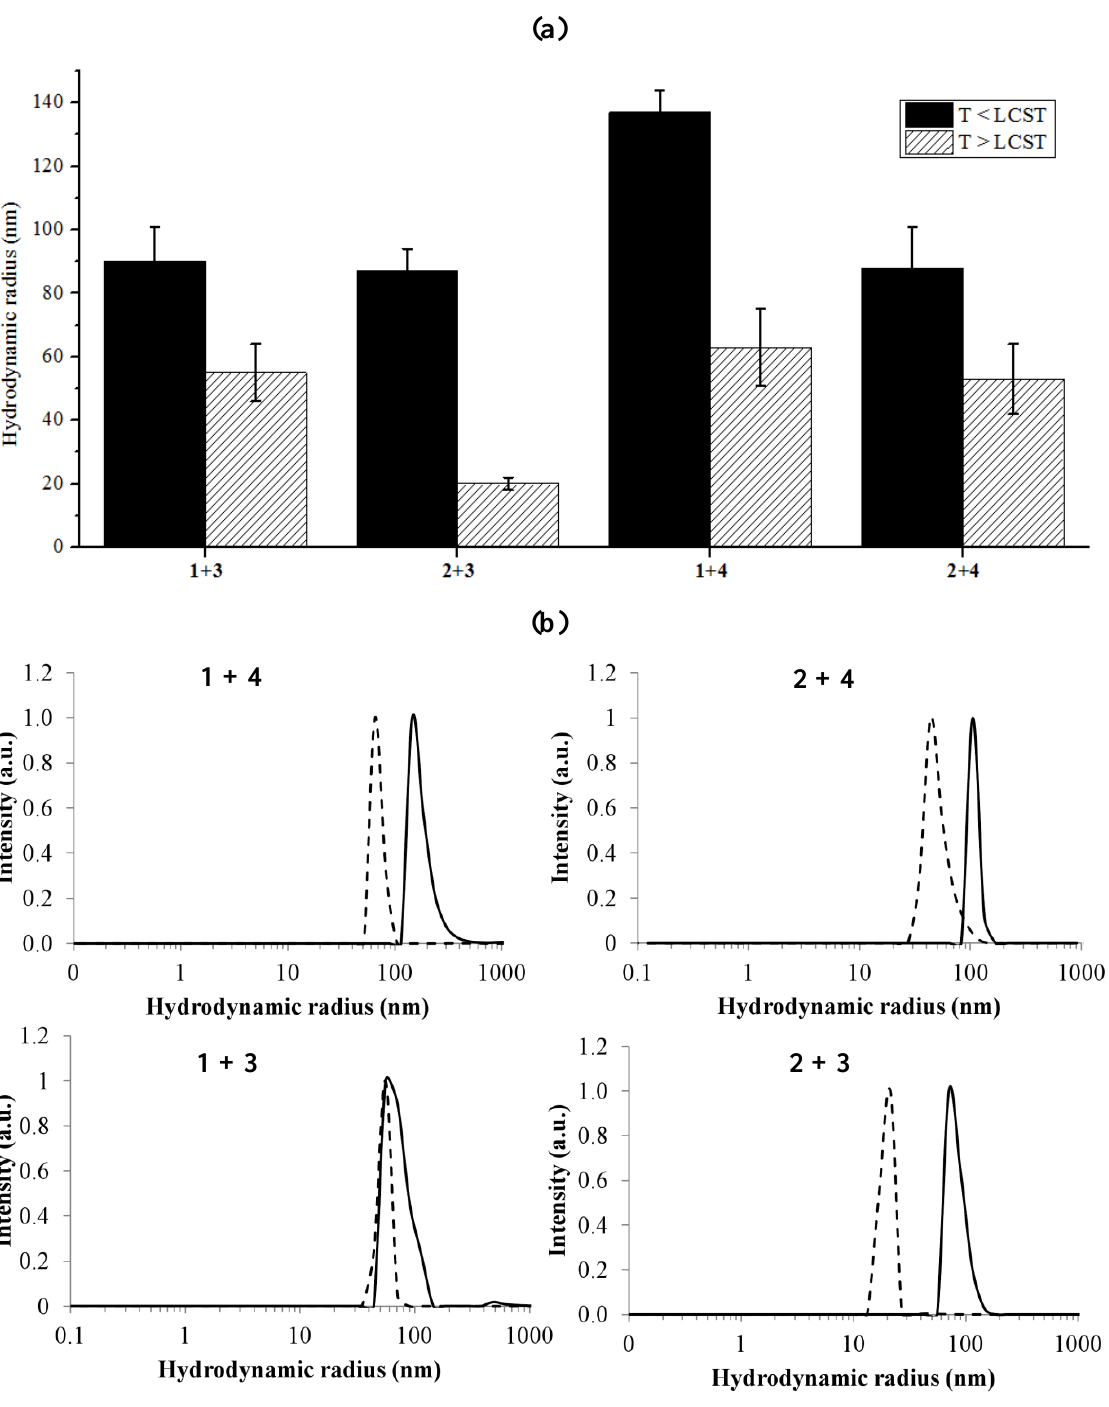
Figure 7. ( a ) Average hydrodynamic radius below and above the cloud point temperature for two component systems; ( b ) Examples of DLS, showing the hydrodynamic radius below (continuous line) and above (dotted line) the phase transition temperature of two component